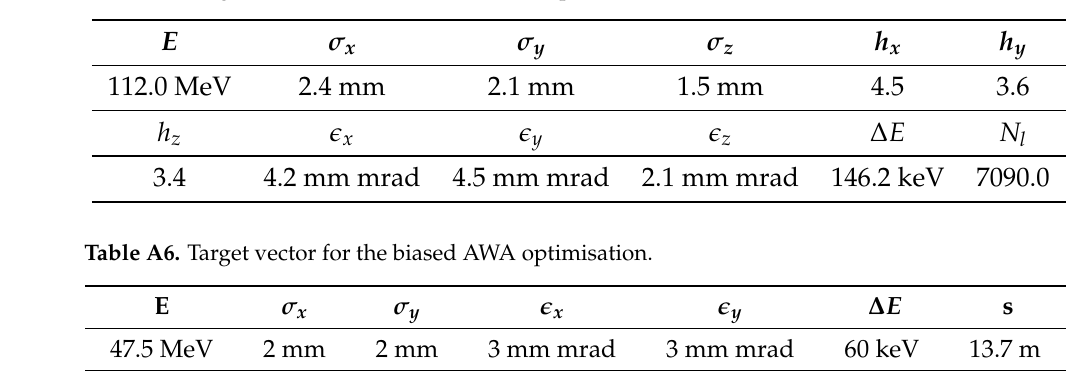
Table A5. Target vector for the biased IsoDAR optimisation.